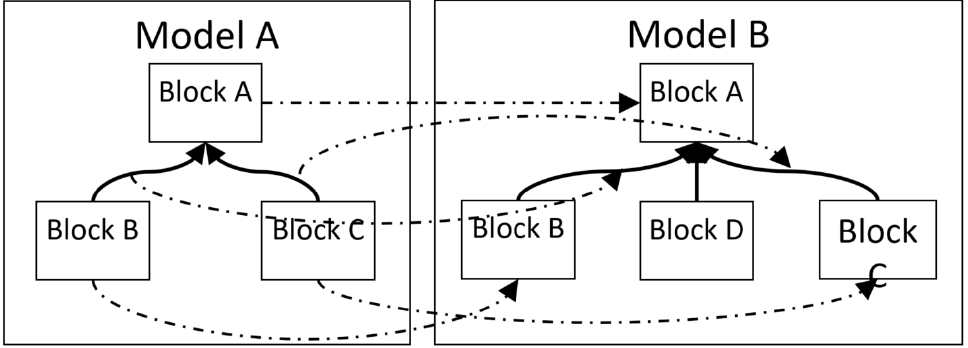
Figure 9. An injection between two